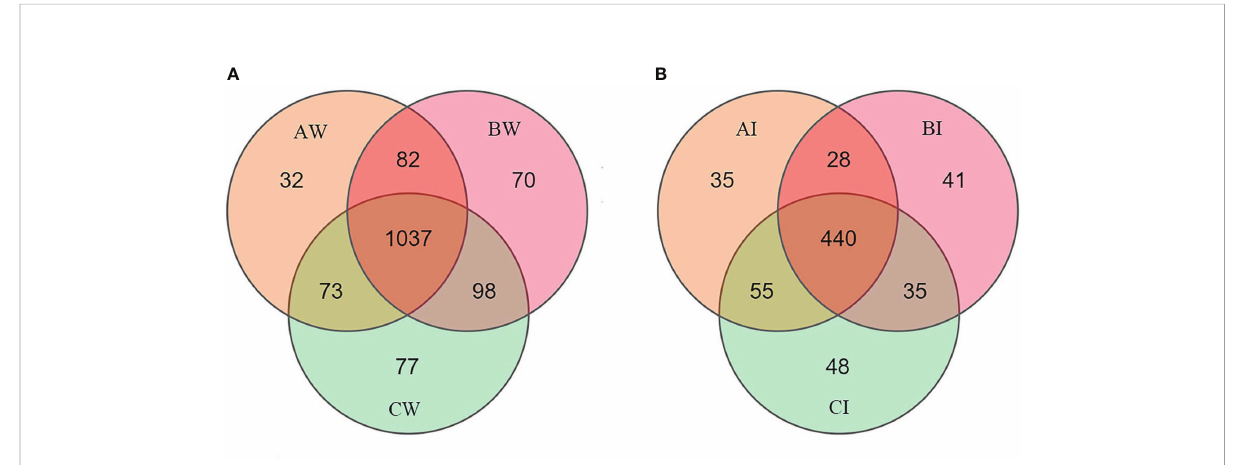
FIGURE 3 Venn diagram showing the unique and shared OTUs in culture water (A) and intestine (B) of L. vannamei with sodium humate (BW, BI) and sodium humate with probiotics (CW, CI). OTUs were de fi ned at the 97% similarity